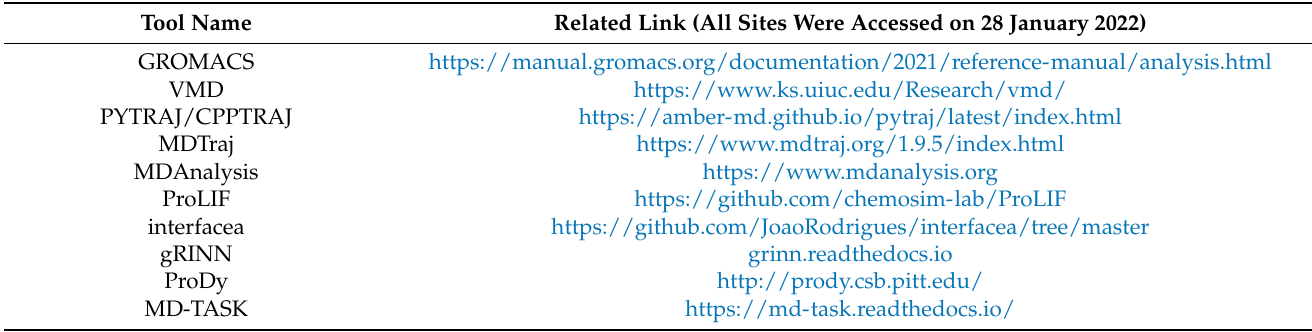
Table 1. List of the described MD analysis tools that can be used to dissect interface dynamics. Tool